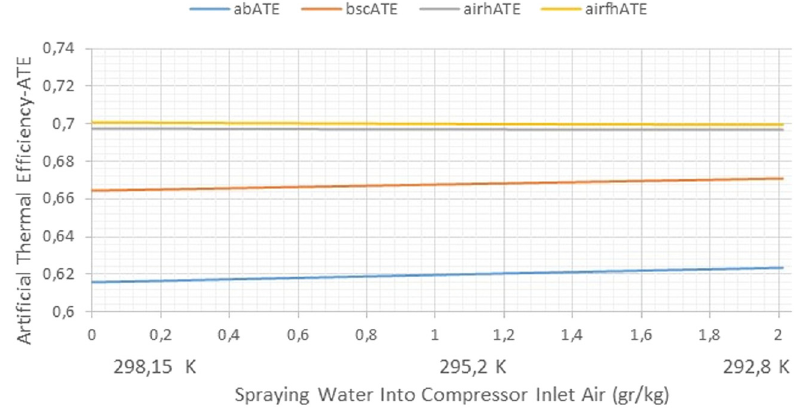
Figure 13: Variation of the ATE with spraying water into compressor inlet air ( g/kg ) for ab, bsc, airh, and airfh cogeneration